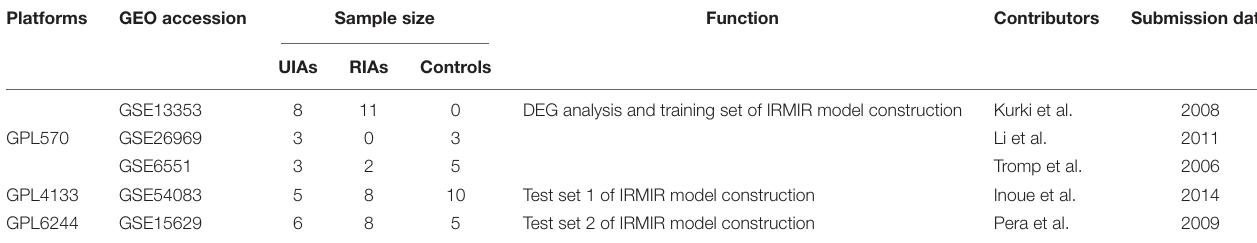
TABLE 1 | Summary of individual studies included.